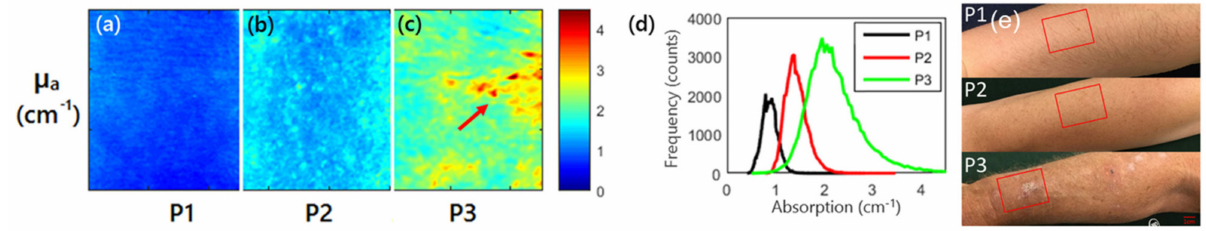
Figure 4. ( a – c ) are absorption maps for three patients at 590 nm, and the red arrow highlights the visible lesion for P3; ( d ) is histogram of the absorption coefficient for the three patients at 590 nm; P1, P2 (without actinic keratosis), and P3 (with actinic keratosis) in ( e ) are three patients expressing various levels of photodamage, corresponding to ( a – c ), respectively (adapted from Ref.